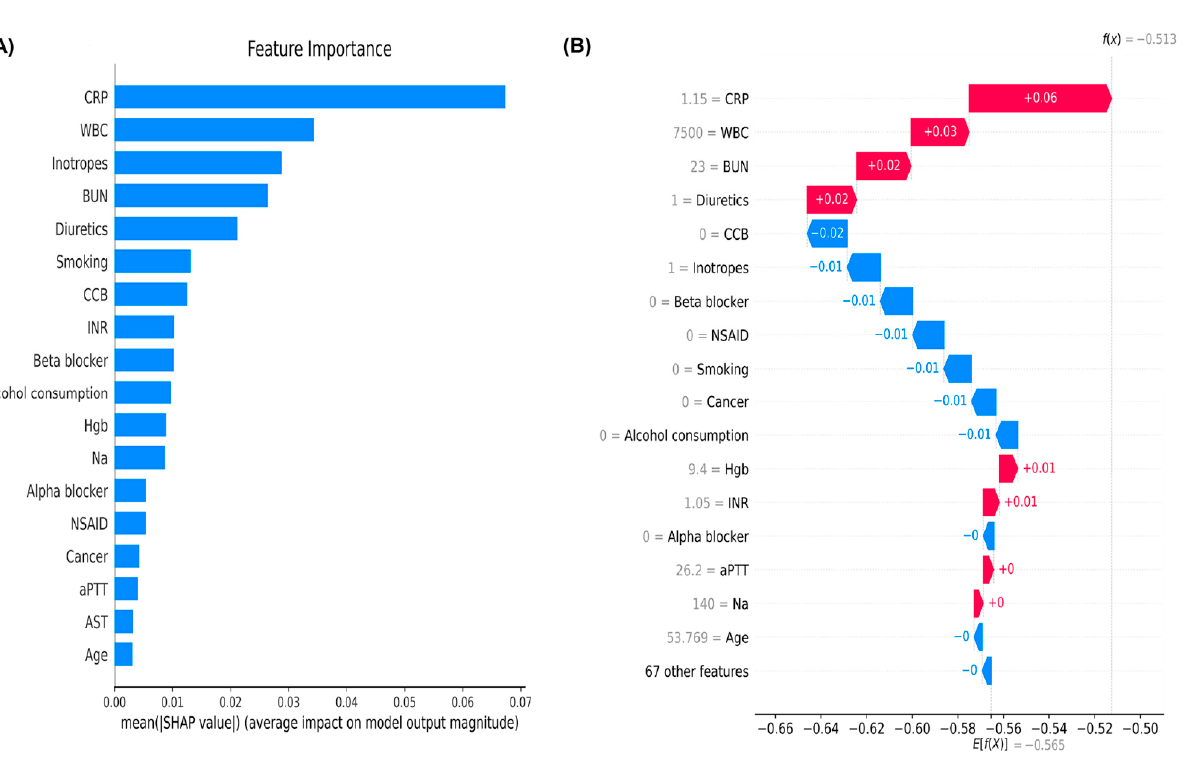
Figure 3. ( A ) The SHAP heatmap plot with the model’s predictions for important features. The heatmap plot function creates a plot with the features on the y-axis, the model inputs on the x-axis,